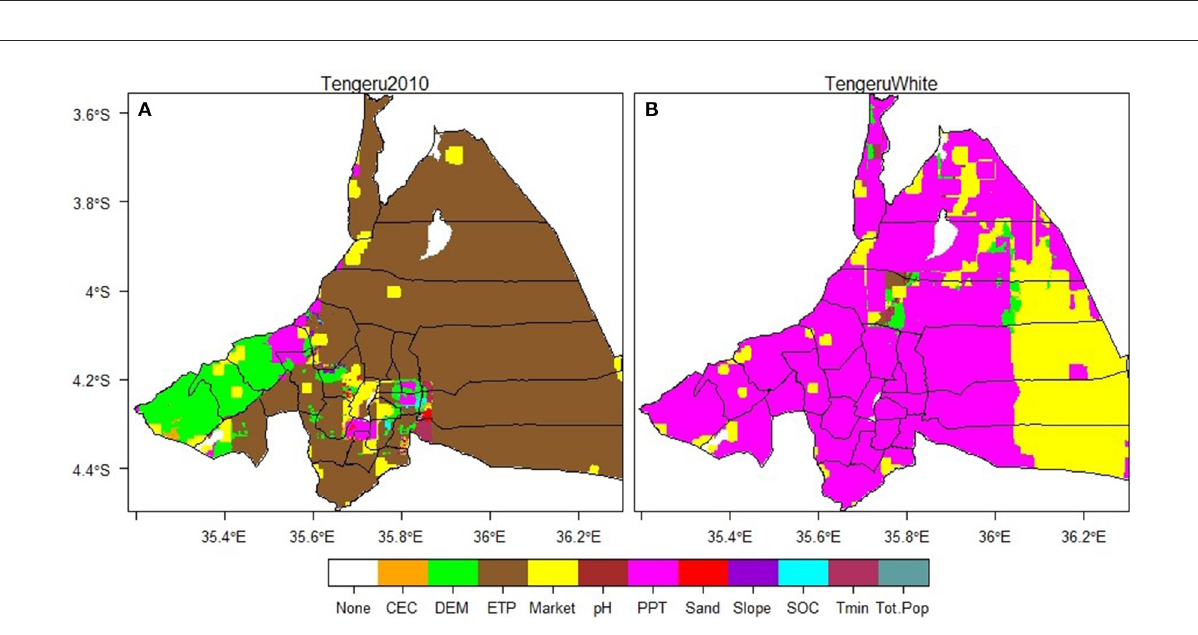
FIGURE7 The spatial variation of the most important covariates (MIC) for two vegetable cultivars grown under improved management practices in Babati district. The zone where none of the covariates was identified as limiting represents vegetable cultivars’ reference trial